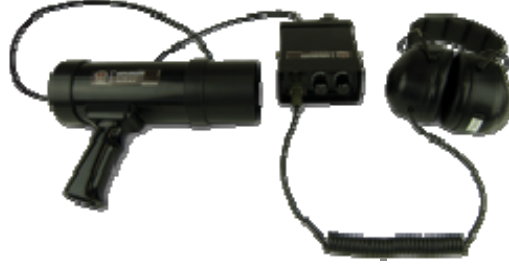
Figure 16 – Е lectronic stethoscope Med – Eng Рис . 16 – Электронный стетоскоп Med – Eng Слика 16 – Електронски стетоскоп Med –